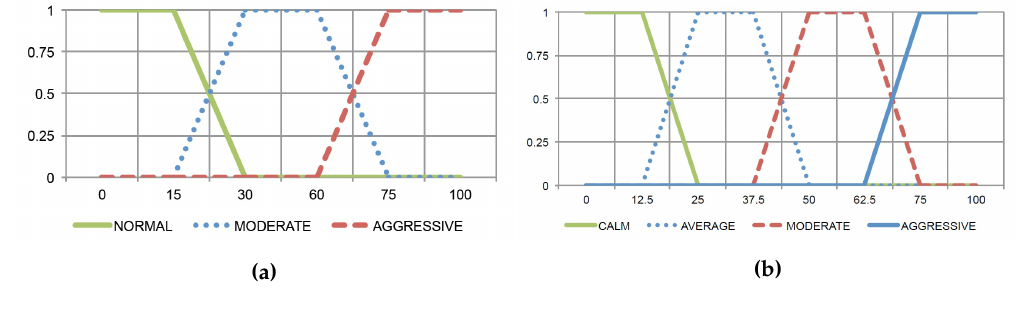
Figure 9. Deviation in the output variable categorization in driver scoring applications. ( a ) Output Fuzzy Set [84]; ( b ) Output Fuzzy Set